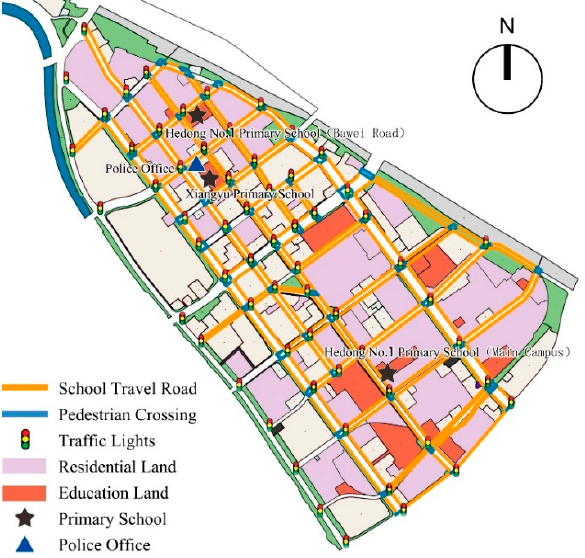
Figure 21. School Travel Routes Planning of the Study Area.